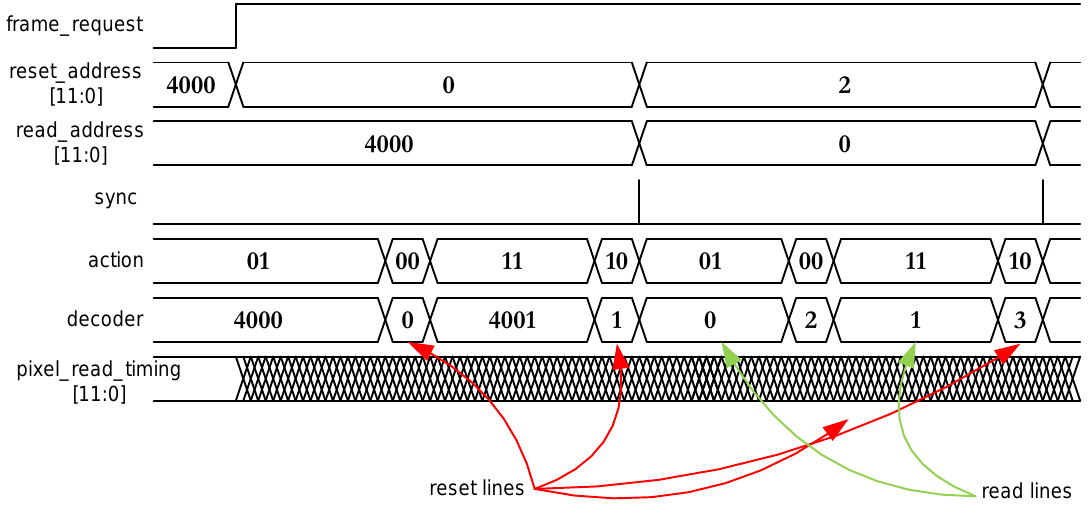
Figure 5. Sequence of the beginning of a frame request in STD mode. Table 1. Operations in STD mode according Action value.